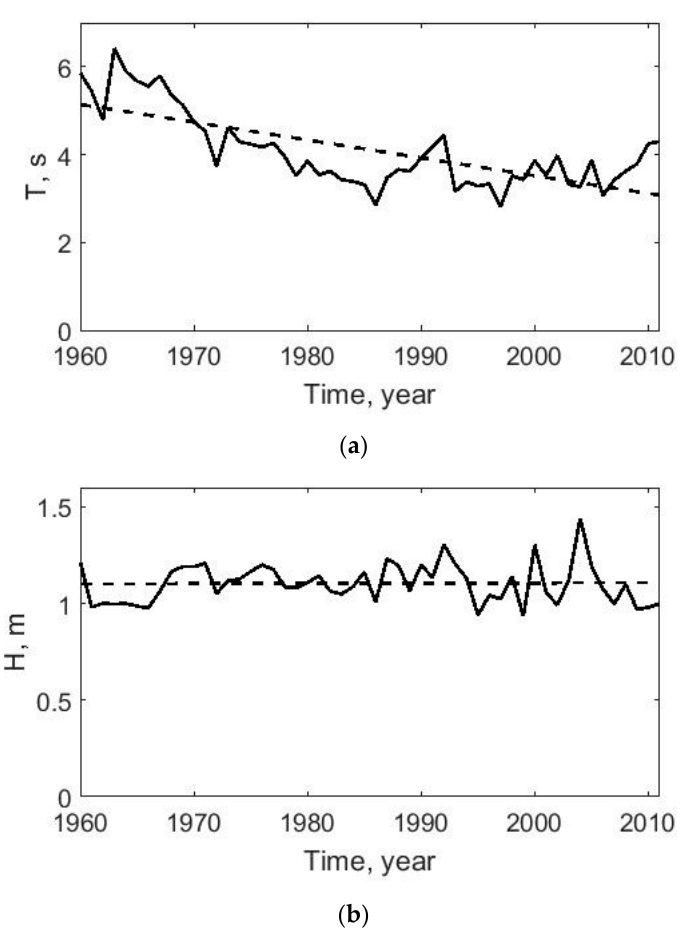
Figure 2. Changes of average annual wave periods ( a ) and heights ( b ), VOS data.